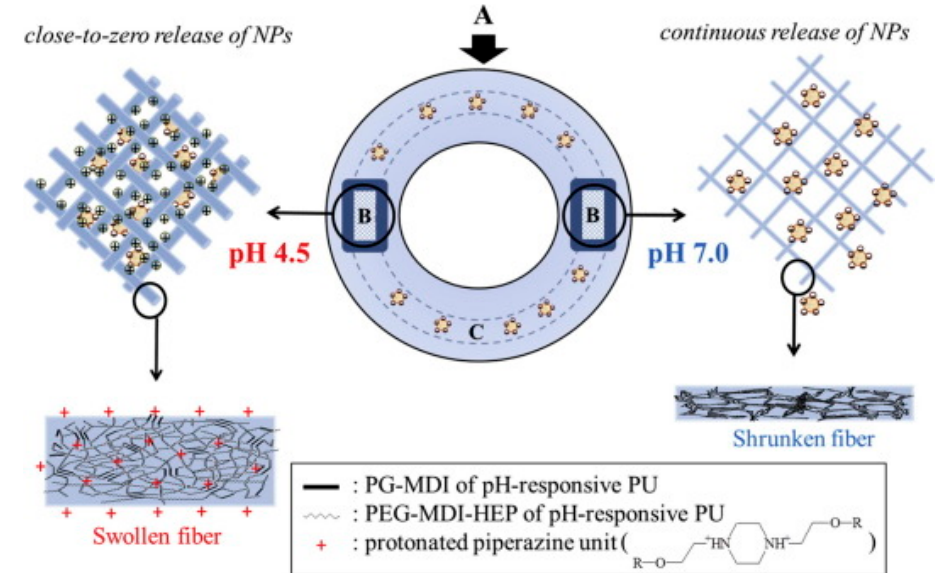
Figure 8. Diagram of the electro spun porous pH-responsive membrane as a “window” membrane in reservoir-intravaginal rings for controlled release of siRNA-loaded nanoparticles. ( A ) intravaginal ring; ( B ) window membrane; ( C ) reservoir. pH-responsive changes in the morphology of the membrane and electrostatic interaction between the pH-responsive membranes and anionic nanoparticles contribute to the release of nanoparticles. Adapted from “Design and Development of pH-responsive Polyurethane Membranes for Intravaginal Release of Nanomedicines” by Kim et al. [125].